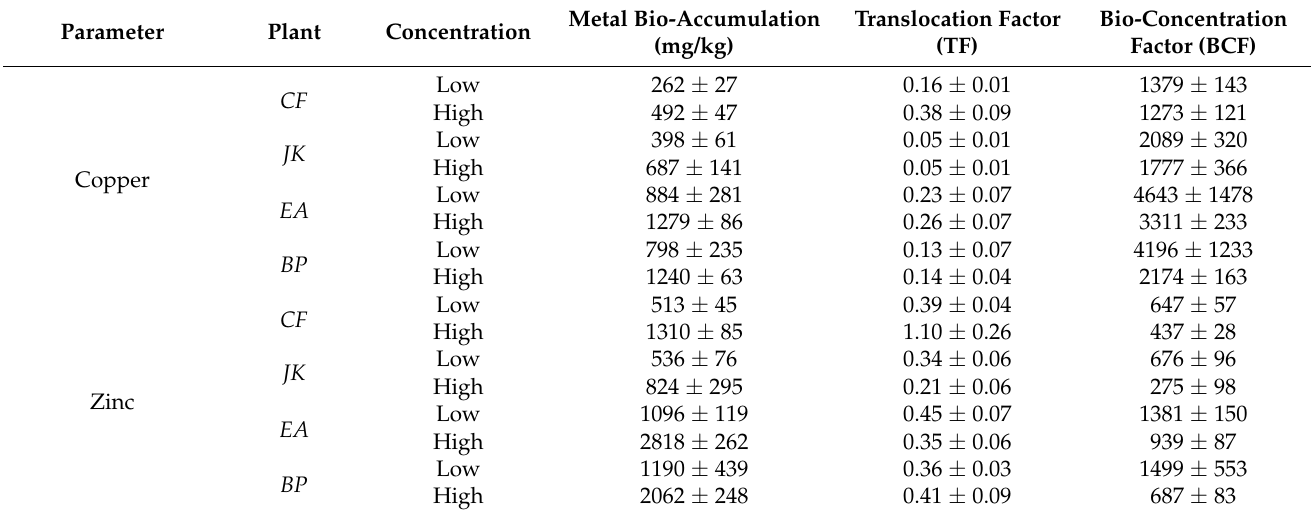
Table 4. Metal bio-accumulation within plant tissue of this study.